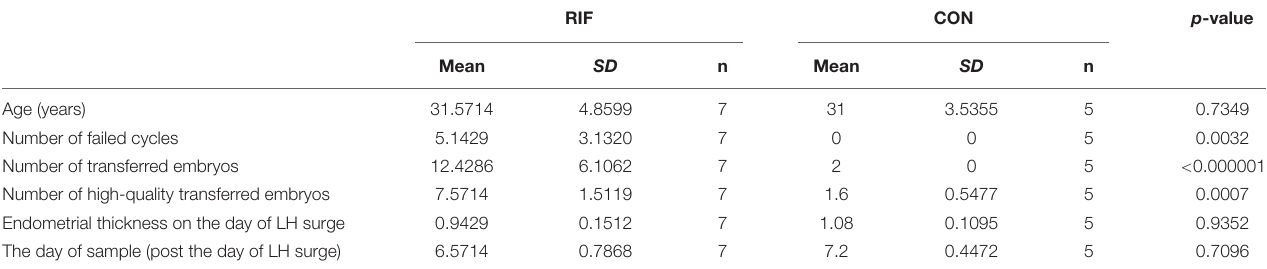
TABLE 1 | Clinical characteristics of